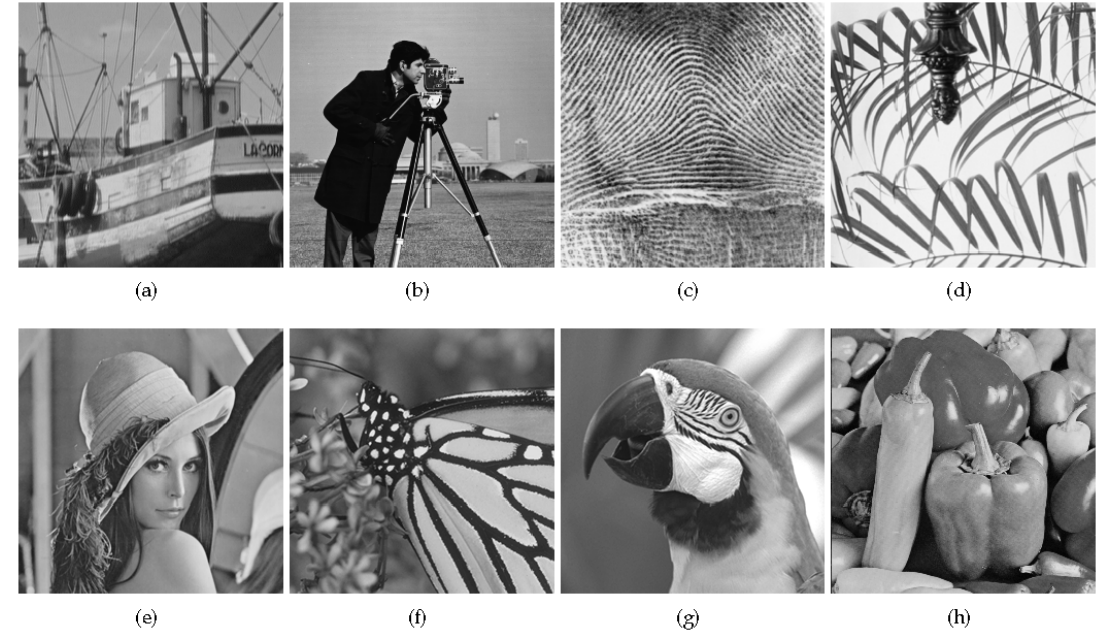
Figure 3. Eight test images. ( a ) Boats. ( b ) Cameraman. ( c ) Fingerprint. ( d ) Leaves. ( e ) Lena. ( f ) Monarch. ( g ) Parrots. ( h )